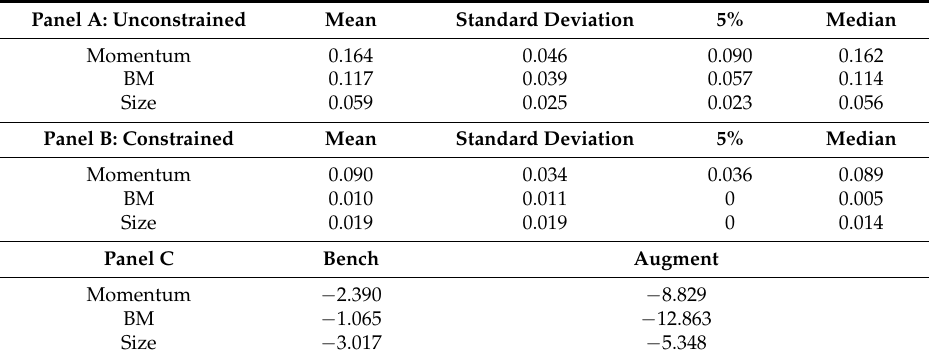
Table 3. Posterior Distribution of the DSharpe Measure Using Model 1